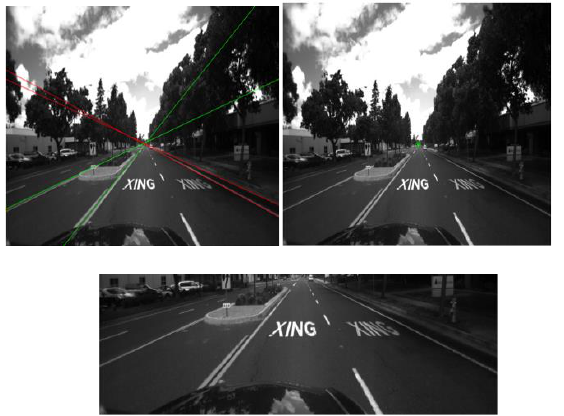
Figure 10. Colour CNN classification